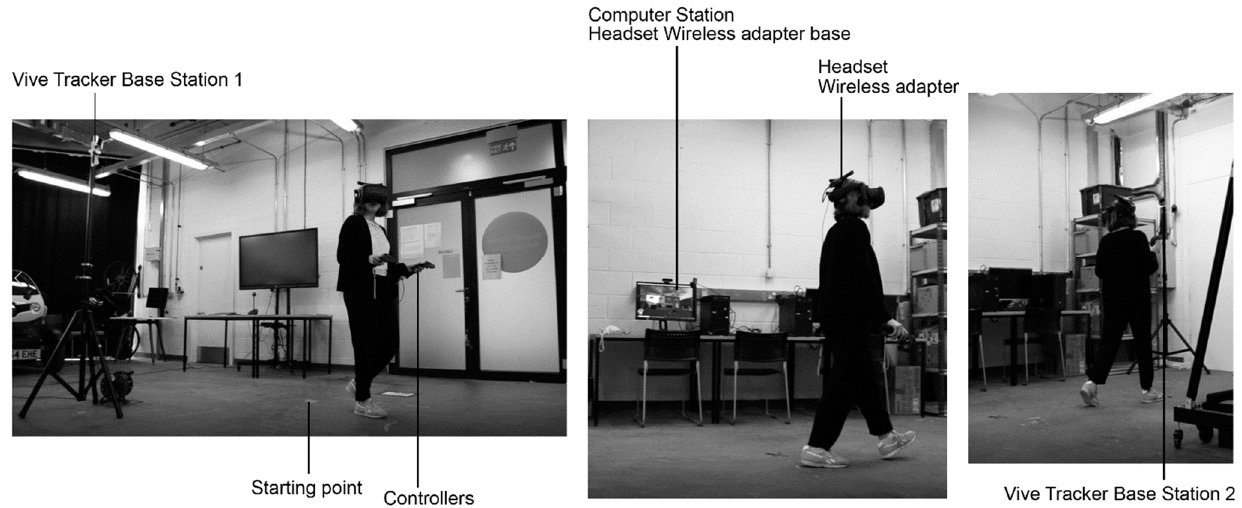
Figure 5. Virtual reality setup and walking area. Tracker base stations face each other diagonally, defining the walking area. The VR headset is fitted with a wireless adapter, of which the base is attached to the computer’s monitor, which allows free movement within the walking area.